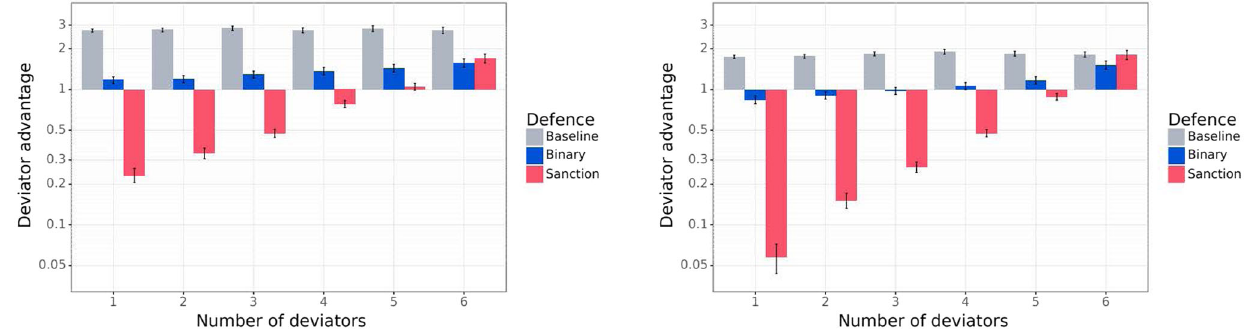
Fig. 7 | Non-deviator agents (Baseline Negotiators, Binary Negotiators, and a population of Binary Negotiatorssigni fi cantlylowers the advantage of Deviators, Sanctioning Agents) playing against Conditional Deviators. Left: Mutual Pro- ascomparedto apopulation ofBaseline Negotiators. While Deviatorsmaystillwin posalprotocol.Right:Propose-Chooseprotocol.Weconsidermultiplegames,each moreoftenthanBinaryNegotiatorswhentherearefewBinaryNegotiators,thegap with agents of exactly two types: either k Deviators and 7 − k Baseline Negotiators, ismuchsmallerthantheonearisingwithBaselineNegotiators.Further,Sanctioning or k Deviators and 7 − k Binary Negotiators, or k Deviators and 7 − k Sanctioning Agents offer a much stronger defense against Deviators. When there are more between the average winrate W dev of a Condi- Agents. The y-axis is the ratio W dev W Sanctioning agents than Deviators, a Deviator wins the game much less frequently def tional Deviator and the average winrate W def of a Defensive agent (so values lower than a Sanctioning than1indicateaDefensiveagentoutperformsaDeviatoragent).Inbothprotocols,